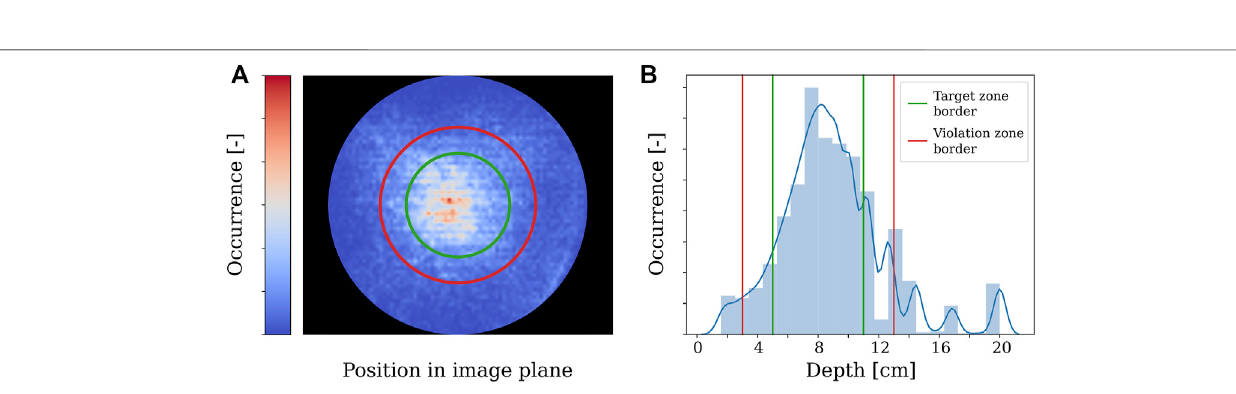
FIGURE 16 | Distribution of dominant-hand tooltip presence across all the experiments in the 2D image and viewing direction.